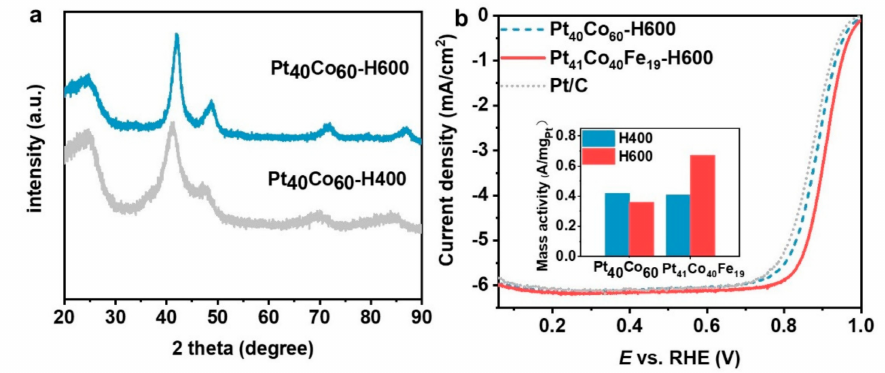
Figure 6. The comparison of Pt 41 Co 40 Fe 19 and Pt 40 Co 60 . ( a ) The XRD patterns of Pt 40 Co 60 -H400 and Pt 40 Co 60 -H600; ( b ) the activities of Pt / C, Pt 40 Co 60 and Pt 41 Co 40 Fe 19